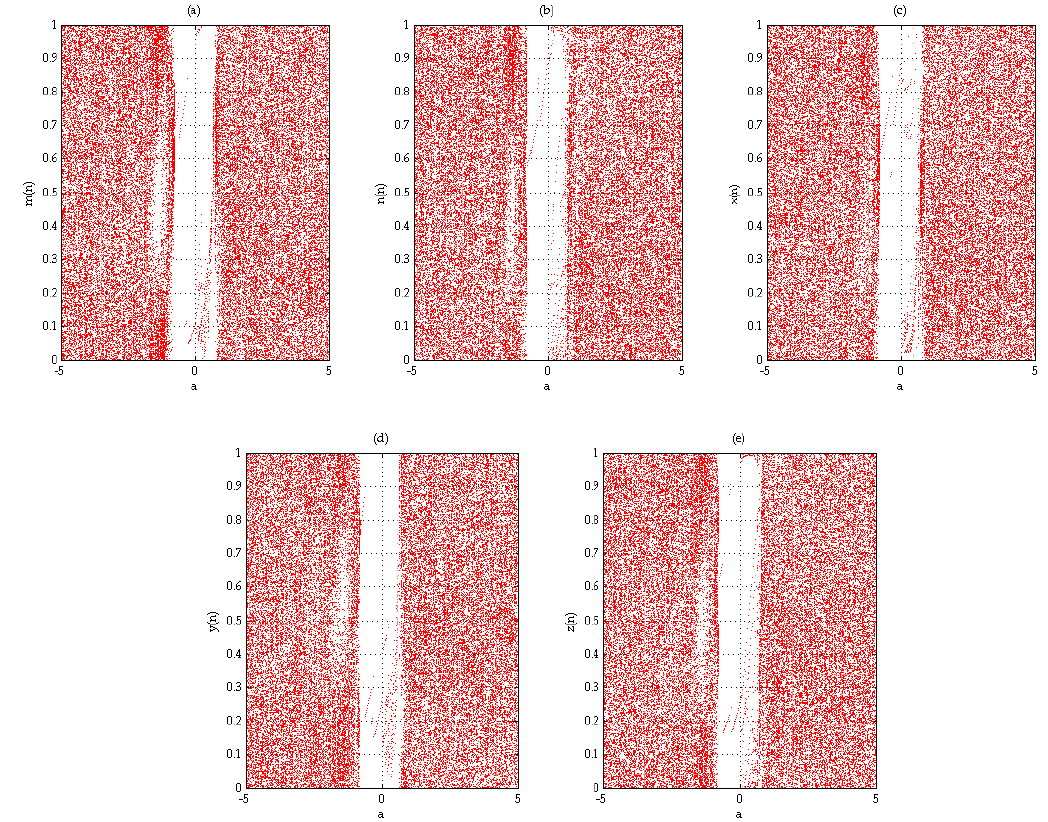
Figure 8. Five-dimensional bifurcation diagram of system (2): ( a ) a -M bifurcation diagram; ( b ) a -N bifurcation diagram; ( c ) a -X bifurcation diagram; ( d ) a -Y bifurcation diagram; ( e ) a -Z bifurcation diagram.